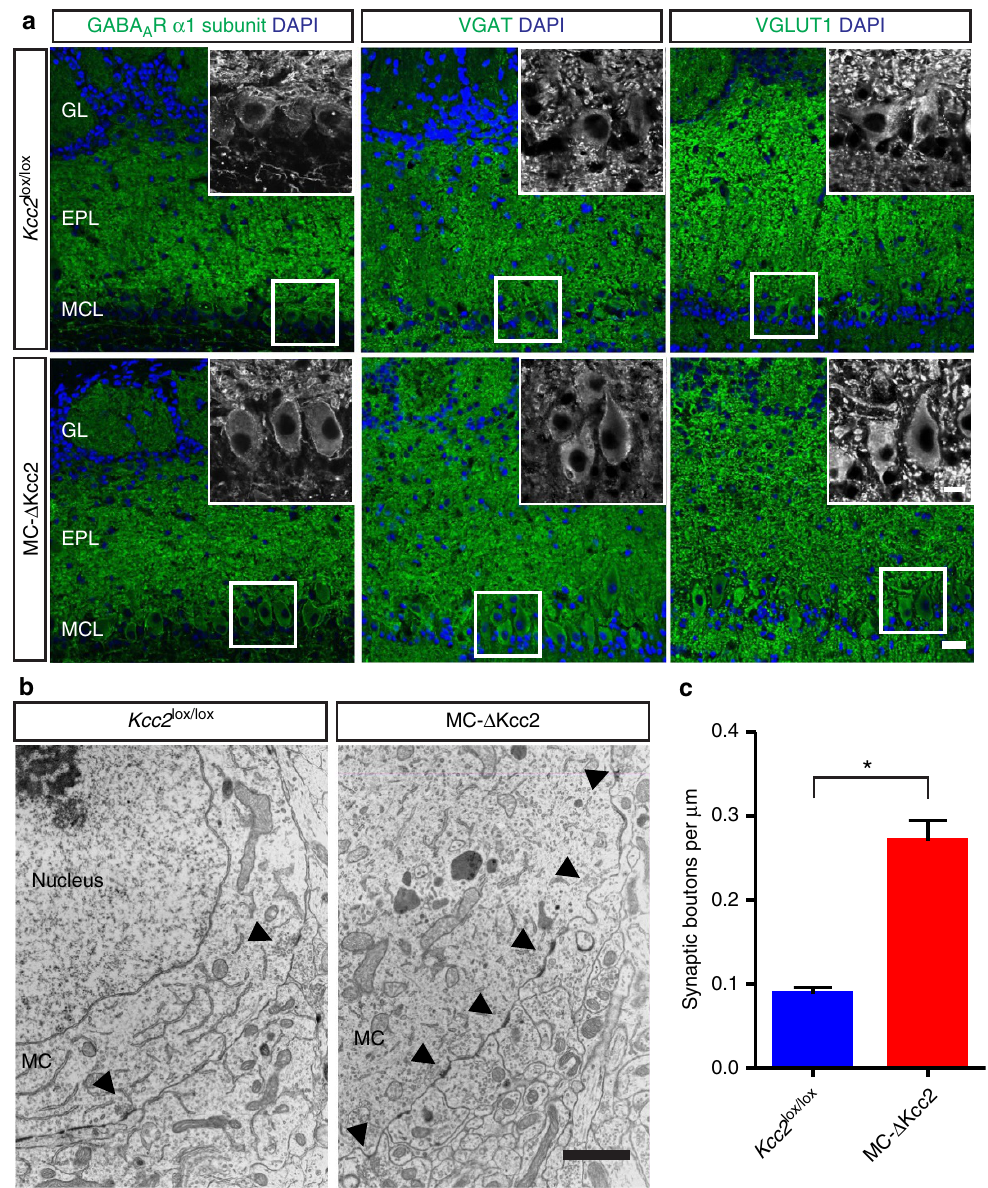
Figure 3 | Increased number of synapses at mitral cell somata of MC- D Kcc2 mice. ( a ) Immunofluorescent labelling of markers of inhibitory (GABA A receptor subunit a 1; vesicular GABA transporter, VGAT) and excitatory (vesicular glutamate transporter 1, VGLUT1) synapses in 10- m m-thick OB slices of MC- D Kcc2 mice and Kcc2 lox/lox mice. Scale bar, 25 m m. Insets, higher magnification of areas indicated by white boxes. Scale bar, 10 m m. ( b ) Electron micrographs of perisomatic region of MCs from MC- D Kcc2 mice and Kcc2 lox/lox mice. Arrows indicate contacting synaptic boutons (inhibitory and excitatory), characterized by a dense postsynaptic density and clustered vesicles either at the side of the MC or within the synaptic bouton. Scale bar, 500nm. ( c ) Average number of synapses per membrane perimeter of MC- D Kcc2 mice and Kcc2 lox/lox mice. n ¼ 4 mice per genotype (with 8–10 cells per mouse) were analysed. Mean þ s.e.m. is displayed. Means are statistically different with * P p 0.05, Mann–Whitney test. EPL, external plexiform layer; GL, glomerular layer; MCL, mitral cell